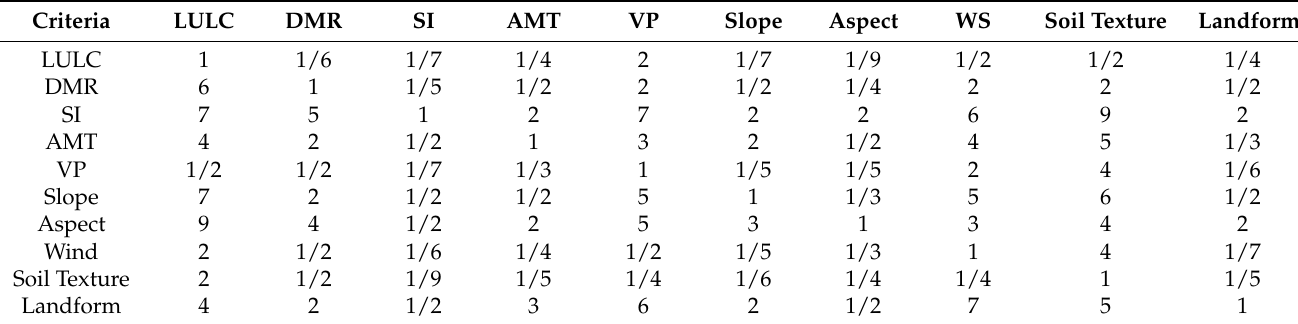
Table 7. Pairwise comparison matrix of the adopted criteria influencing site-suitability for the development of solar farms. AHP